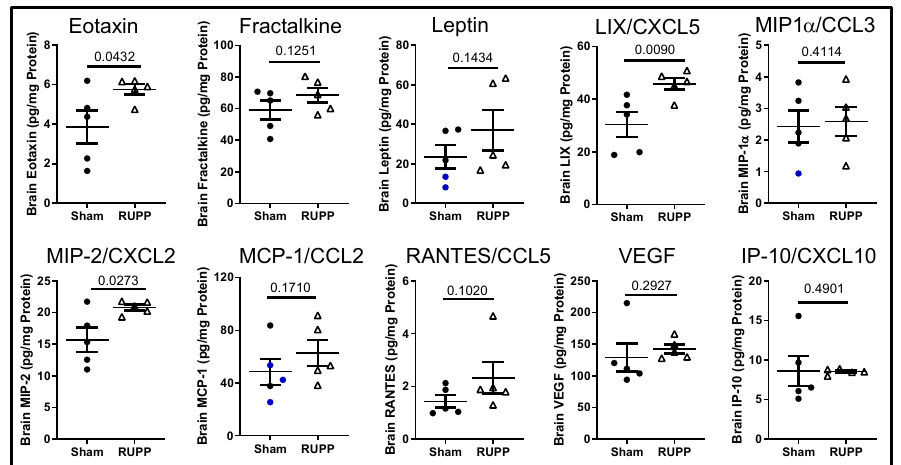
Figure 4. Changes in chemokines / growth factors in fetal brains. Placental ischemia exposure increased eotaxin, LIX, and MIP2 levels. Not shown are: EGF, G-CSF, GM-CSF, and GRO / KC. Blue points represent extrapolated values (one value below lowest detectable value and normalized to protein concentration). Values for individual fetuses ( n = 5 fetuses per group) are shown along with the mean ± SEM. Data were analyzed using unpaired t -tests, and p -values are indicated.